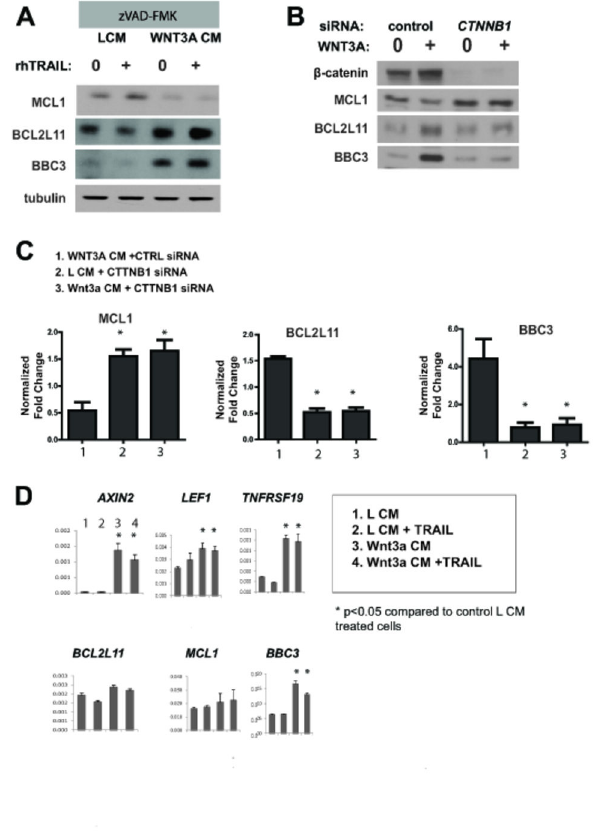
Figure 3. Wnt/β-catenin activation enhances the expression of the pro-apoptotic proteins BIM and PUMA and diminishes levels of anti-apoptotic MCL1. A) A375 melanoma cells were treated with rhTRAIL (20 ng/mL) in the presence of WNT3A or L CM. To inhibit caspase activity, cells were also treated with 100µM zVAD-FMK. Immunoblotting analysis was performed with the indicated antibodies. B) A375 cells were pre-treated with β-catenin ( CTNNB1 ) versus control siRNA. 48 hours later, the cells were treated with WNT3A CM or L CM. Immunoblot analysis was then performed with the indicated antibodies. C) Graphs represent the fold-change in protein expression in (B) from digitally-quantified immunoblots +/- SEM (n=5 blots from independent experiments). Each condition was normalized to control cells treated with L CM + control siRNA. D) A375 melanoma cells were treated with WNT3A CM versus L CM in the presence or absence of rhTRAIL (20ng/mL) in the presence of zVAD-FMK (100µM). After 24 hours, RNA was collected for cDNA synthesis and analysis by quantitative real-time PCR (qRT-PCR). Data represents mean relative expression of the indicated gene based on three replicates/group. Significant differences between groups are indicated.